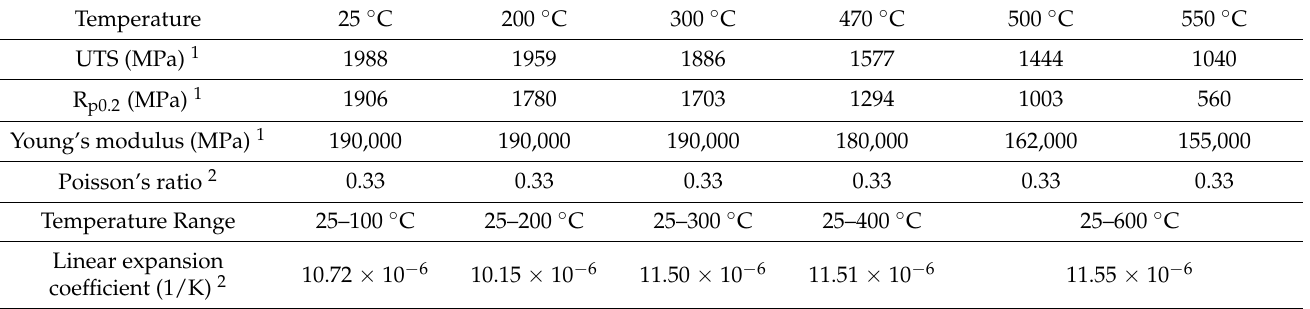
Table 5. Mechanical properties describing the constitutive model of SLM 1.2709 maraging